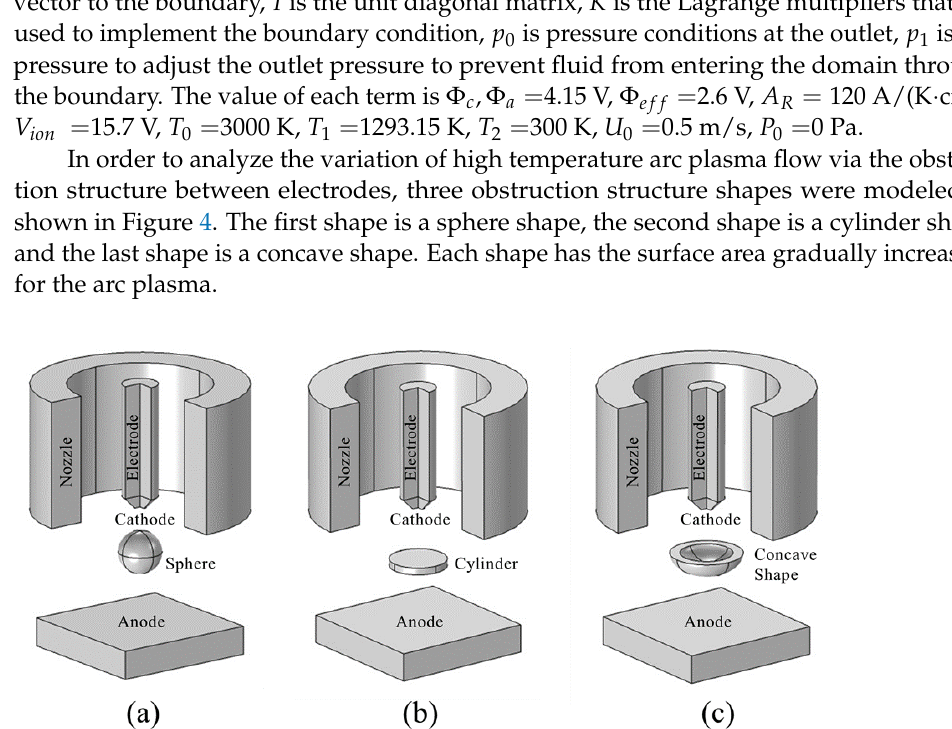
Figure 4. Shapes of the obstruction structures between electrodes: ( a ) Sphere shape; ( b ) Cylinder shape; ( c ) Concave shape.